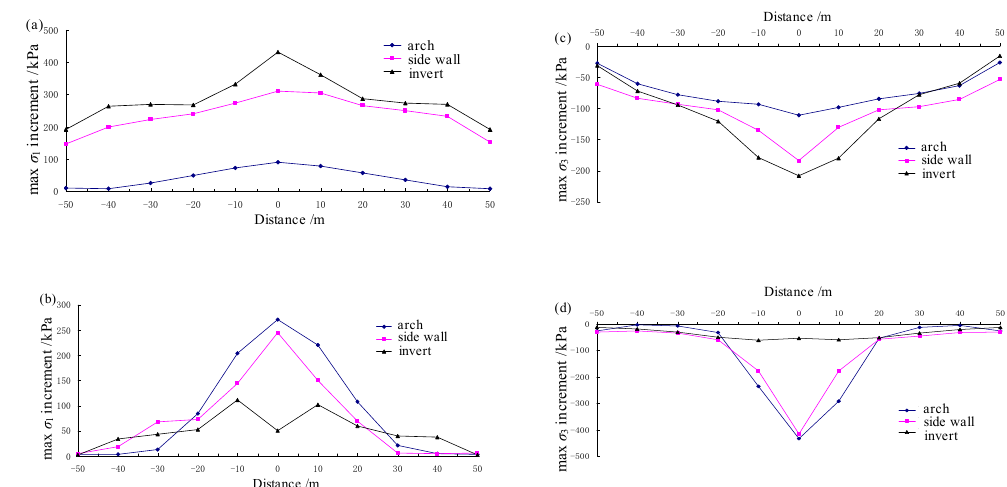
Figure 11. Stress increment comparison due to the train loading: ( a ) and ( b ) show the major principal stress of the upper and lower tunnels, respectively; ( c ) and ( d ) illustrate the third principal stress of the upper and lower tunnels, respectively.